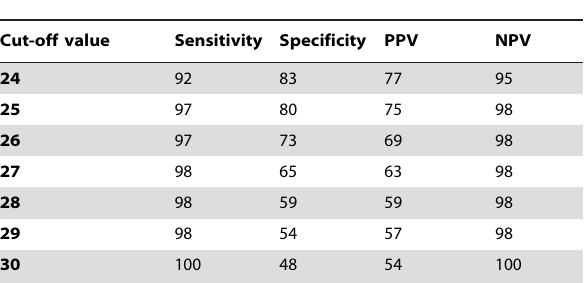
Table 1. Comparison of performance characteristics of the diagnostic test (real-time PCR assay, universal probe) using different PCR Ct cut-off values